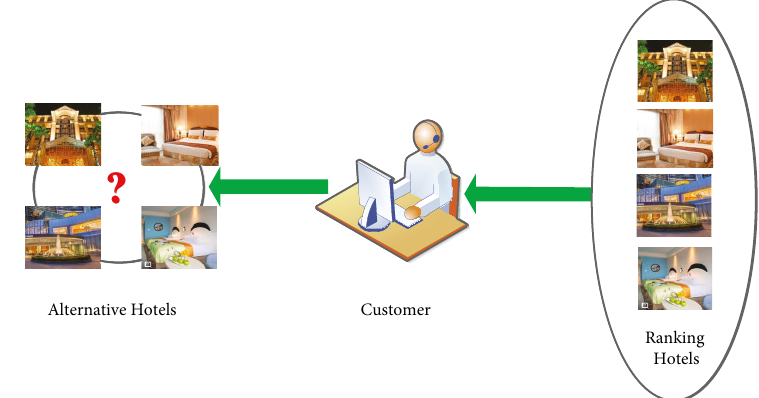
Figure 2. The problem of ranking alternative hotels with online